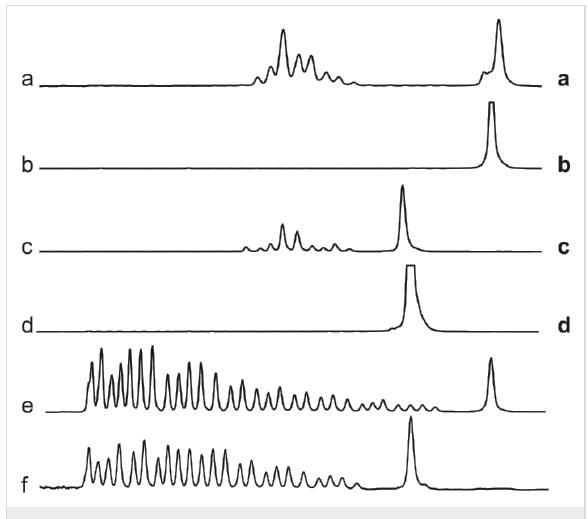
Figure 3: Substrate specificity of conjugates 12 and 14 (150 nM sub- strate, 750 nM conjugate, 50 mM Tris-HCl, pH 8, 37 °C, 20 h). Lane a: conjugate 12 and substrate 15 . Lane b: conjugate 14 and substrate 15 . Lane c: conjugate 14 and substrate 17 . Lane d: conjugate 12 and sub- strate 17 . Lanes e and f: hydrolysis patterns of 15 and 17 (Na 2 CO 3 ).